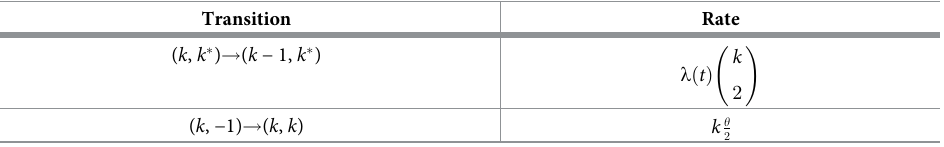
Table 2. The transition rates of the augmented ancestral process A y . The first row gives the rate of a coalescence event of two lineages, while the second row gives the rate for mutation events. Note that only one mutation event is